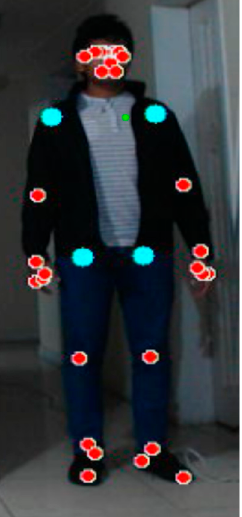
Figure 4. Reference points on a person for the identification of joints.